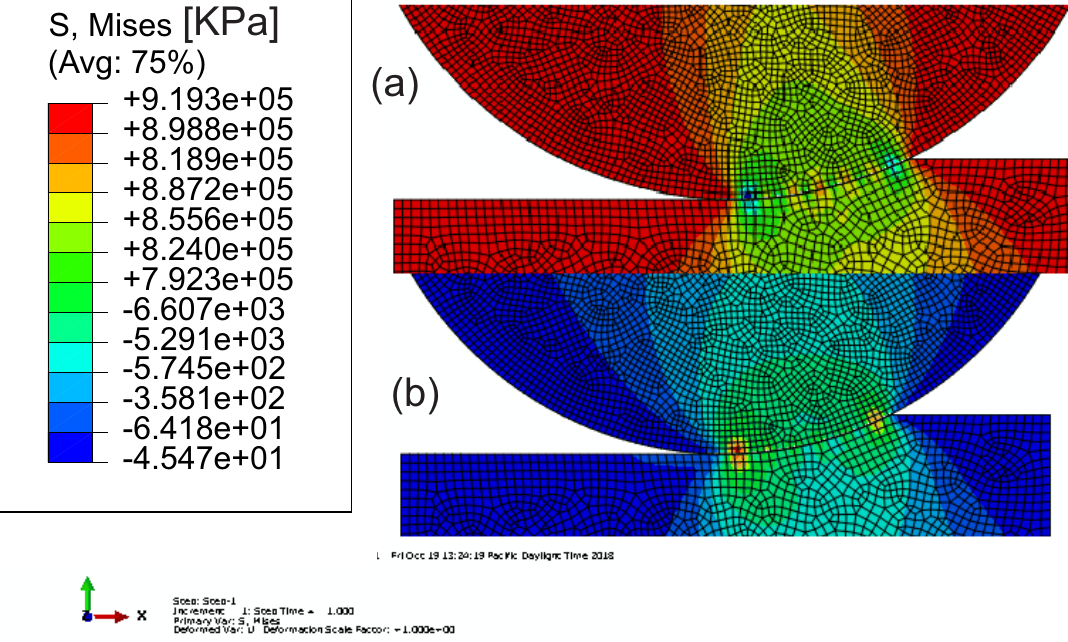
Figure 10. Stress distribution along the arc of contact during plasticity deformation in the global section view where the results from ABAQUS. ( a ) Radial stress distribution, ( b ) Tangential stress distribution. To get a unified equation, let us find the mean rolling die pressure at interface through integration. Considering a volume element of unit width and having a thickness ˜ h with length dx (see Figure